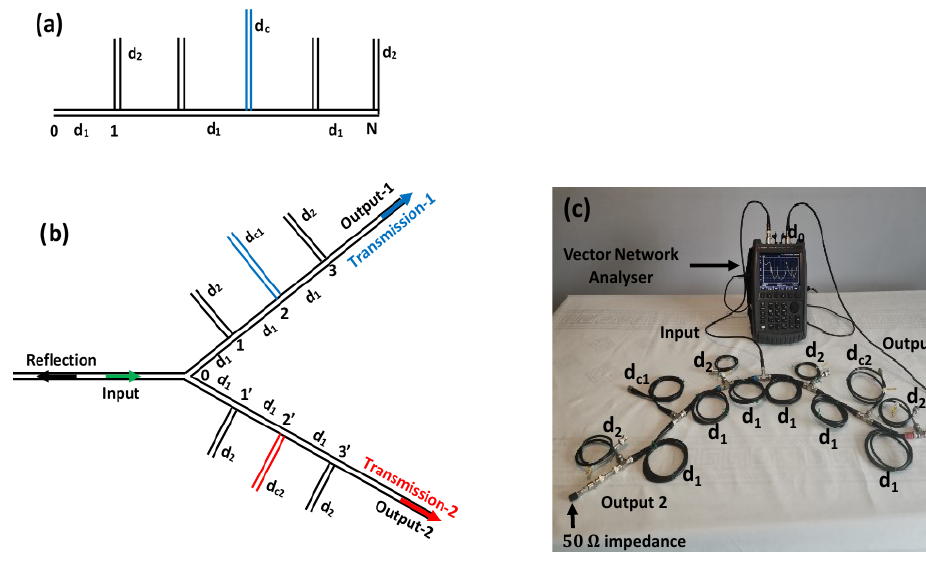
Figure 7. ( a ) Schematic illustration of a finite comb structure with a defect stub. ( b ) Y-shaped demultiplexer formed by comb structures with defect stubs. The stubs are of lengths d 2 , the segments that connect the stubs are of lengths d 1 and the defects are of lengths d c 1 on the output 1 and d c 2 on the output 2. ( c ) Experimental setup of the system in ( b ) performed with standard coaxial cables connected to the vector network analyzer. The boundary conditions at the end of the stubs are H = 0. When one output is connected to the analyzer entrance, the second output is 50 Ohm impedance matching in order to avoid any reflection of the wave at the end of this